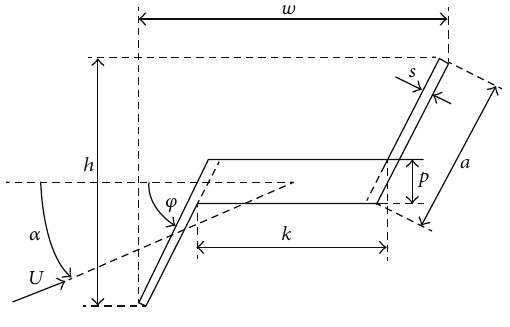
Figure 1: Z-shaped profile parameters.